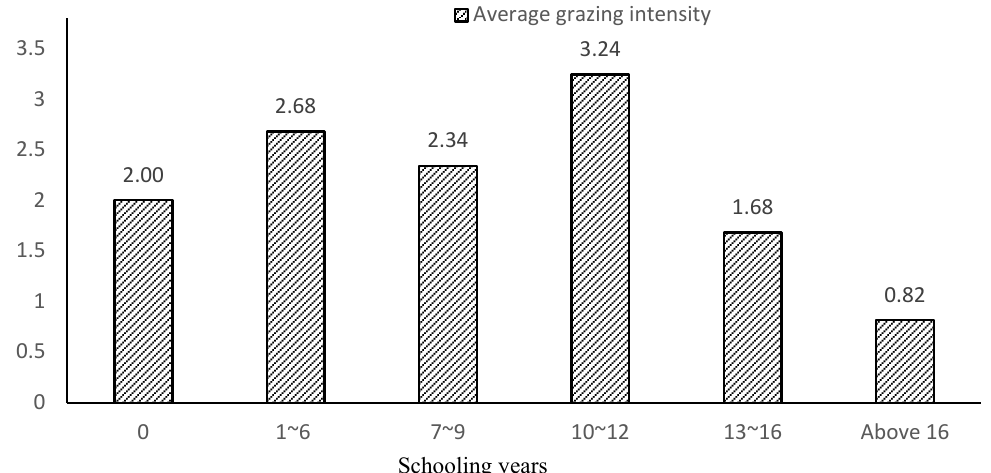
Figure 5. The relationship between schooling years of household head and family’s average grazing intensity.